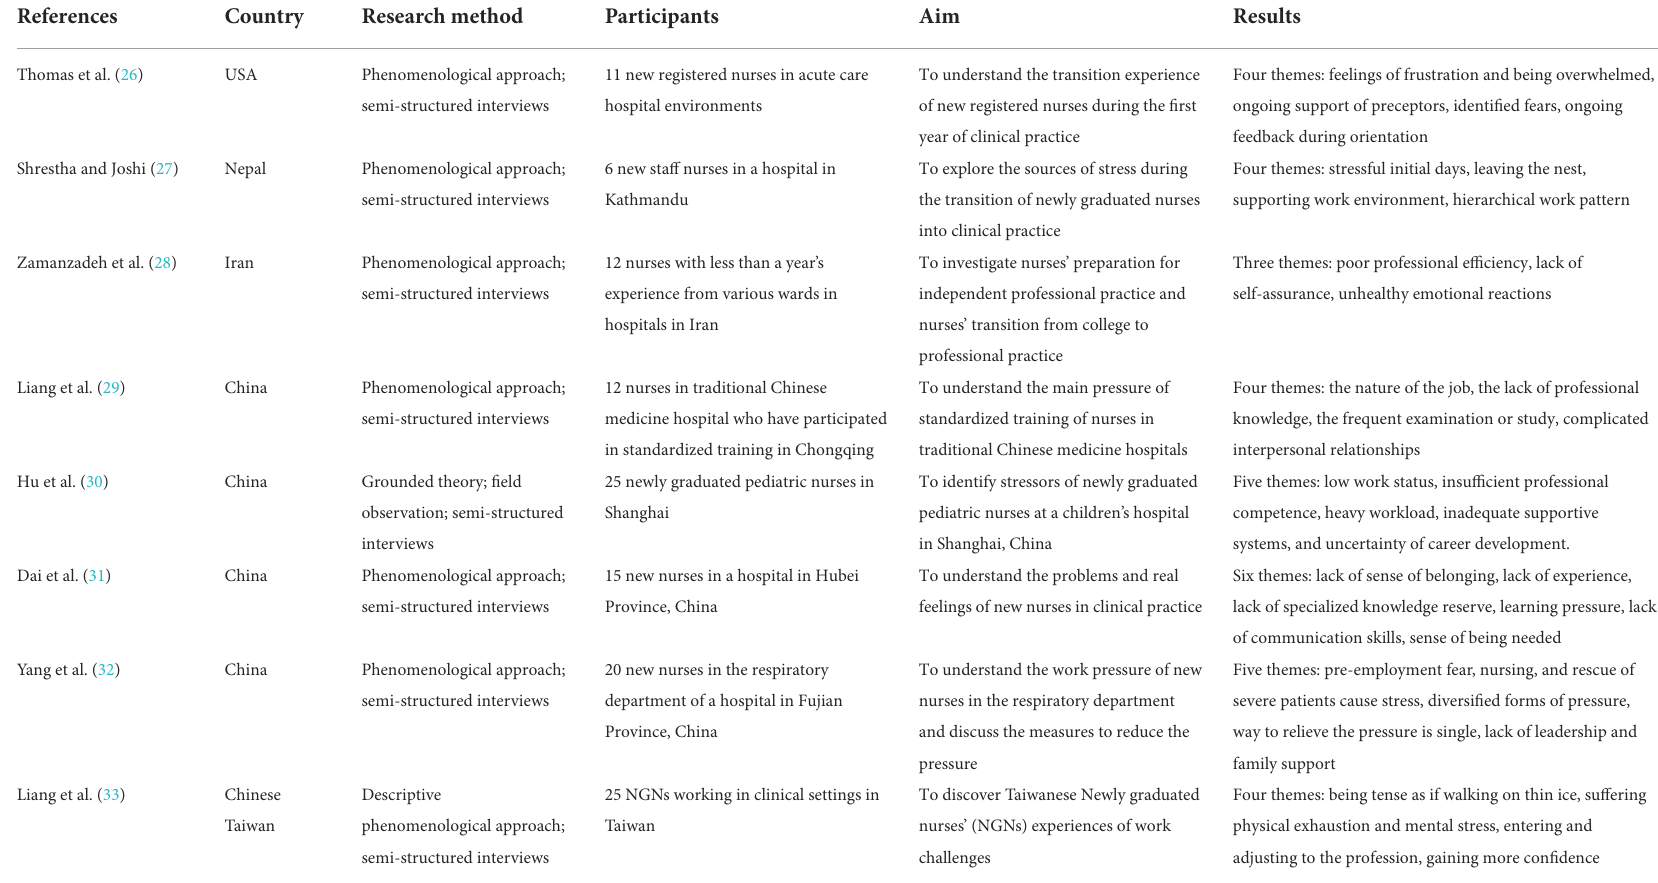
TABLE 2 Key features and characteristics of 13 included